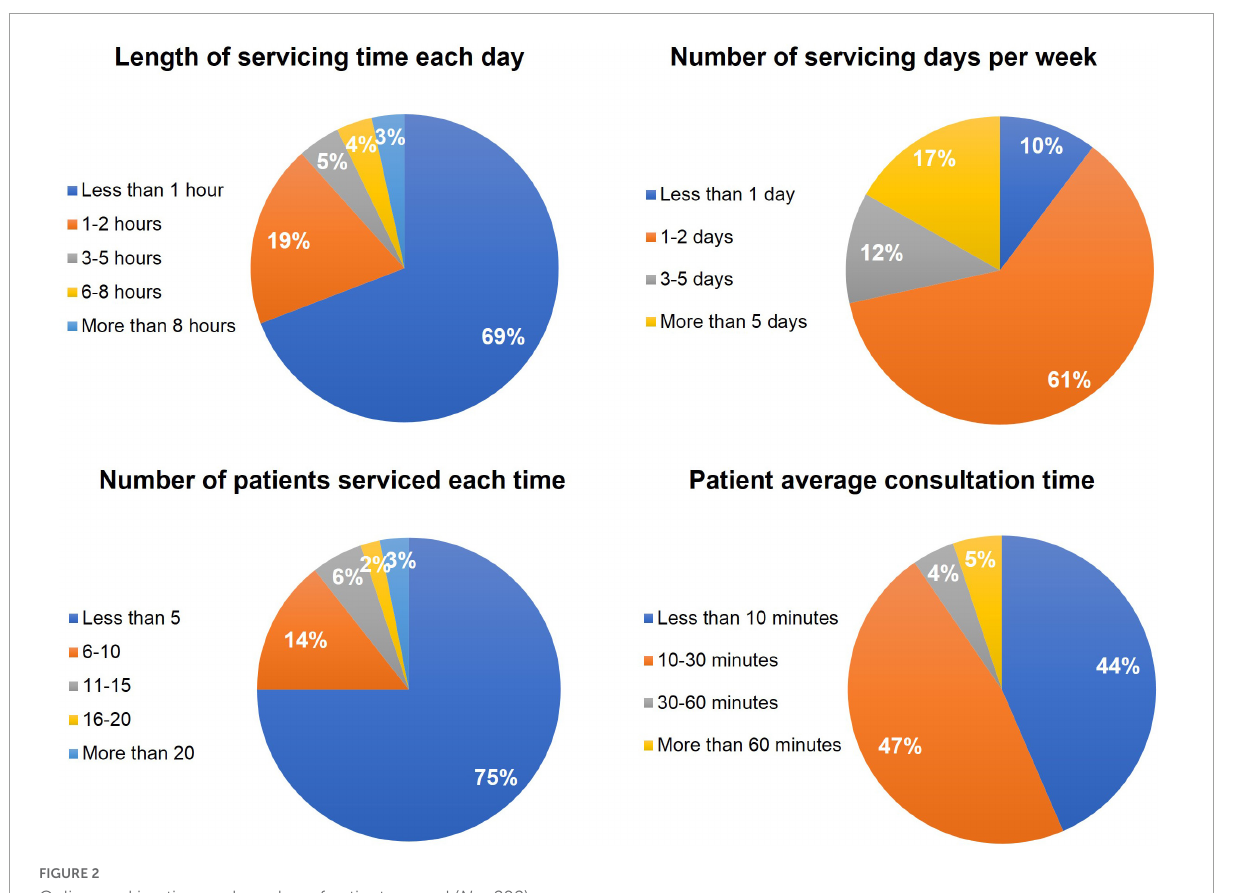
FIGURE2 Online working time and number of patients served ( N =